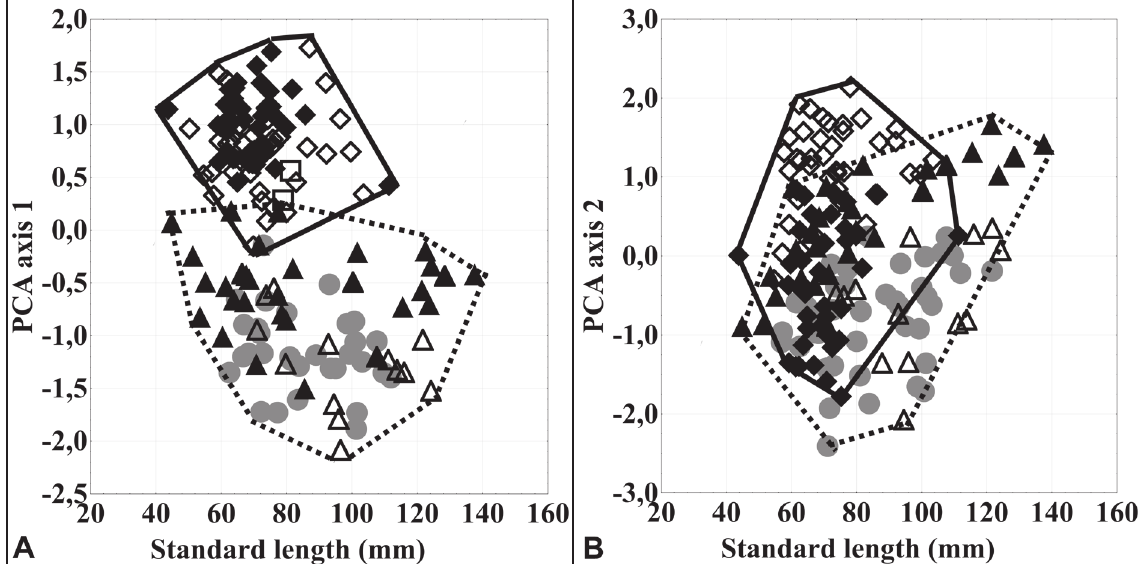
Fig. 2. Plots of PCA scores against standard length for all Astatoreochromis specimens examined. (A) scores on the first axis of a PCA on the meristics and (B) on the second axis of a PCA on the log- transformed morphometrics. Lakes Victoria and Kioga (∆); Lakes Edward-George-Kayanza-Nabugabo- Nakavali-Semliki (▲) ; Akagera basin (●); Lukuga River (□), Malagarazi basin ( ); Rusizi basin ( ). Full line polygon for Lake Tanganyika basin, dashed line polygon for Lake Victoria basin specimens.